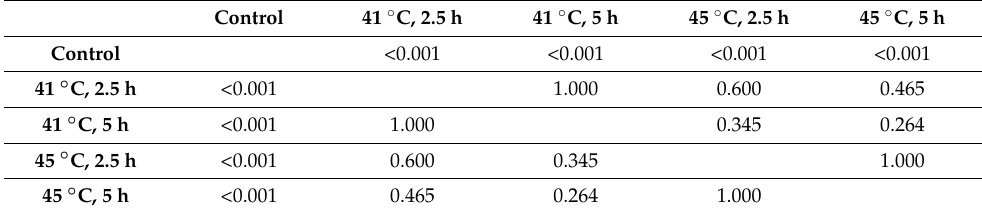
Table 1. Impact of thermotherapy treatment conditions on the number of obtained fungal taxa per acorn tested with multiple comparison of mean ranks for all groups post hoc test (significant p values among treatments are highlighted in red).